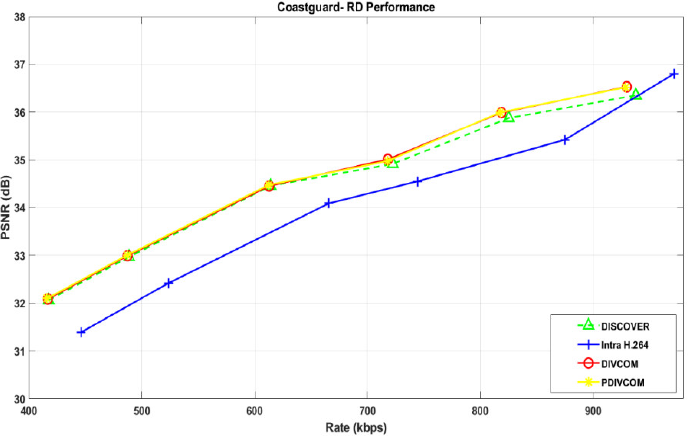
Figure 2. Rate-distortion (RD) performance graphical evaluation of “Coastguard” video sequence with frame rate of 15 Hz and GOP 2.